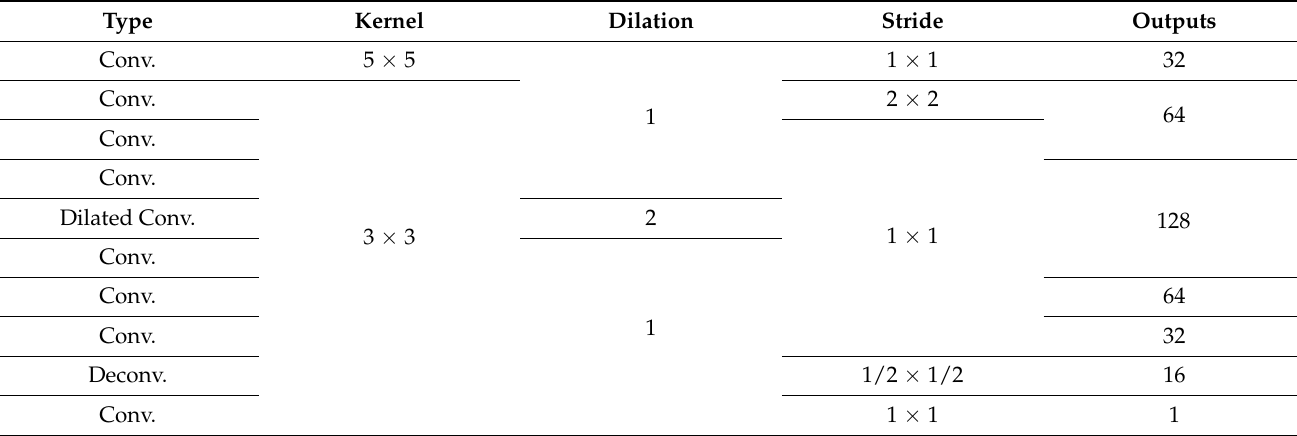
Table 1. Detailed parameters of the generator. The coarse network shares the same parameters with refinement network.